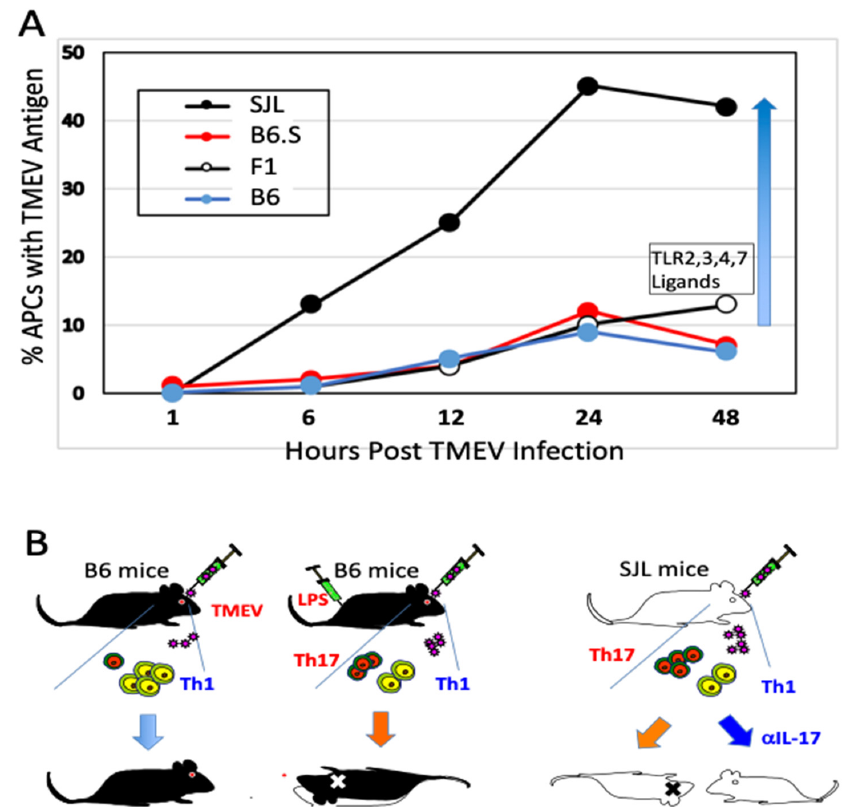
Figure 1. Permissiveness of antigen-presenting cells to Theiler’s murine encephalomyelitis virus (TMEV) infection correlates with susceptibility to the pathogenesis of demyelinating disease. ( A ) Susceptibility of antigen-presenting cells to TMEV infection/replication is directly associated with the development of chronic demyelinating disease. The elevated viral infection/replication leads to elevated inflammatory cytokine production (such as IL-6 and IL-1) which favors stimulation of pathogenic Th17 response over protective Th1 response. ( B ) Levels of Th17 determine the development of TMEV-induced demyelinating disease. Genetically resistant B6 mice induce strong Th1 and weak Th17 responses to TMEV infection. However, B6 mice receiving LPS develop strong Th17 and reduced Th1 responses, and become susceptible to TMEV-induced demyelination [48]. Susceptible SJL mice develop strong Th17 and weak Th1 responses. Injection of SJL mice with anti-IL-17A antibodies prevents the development of TMEV-induced demyelinating disease [65].